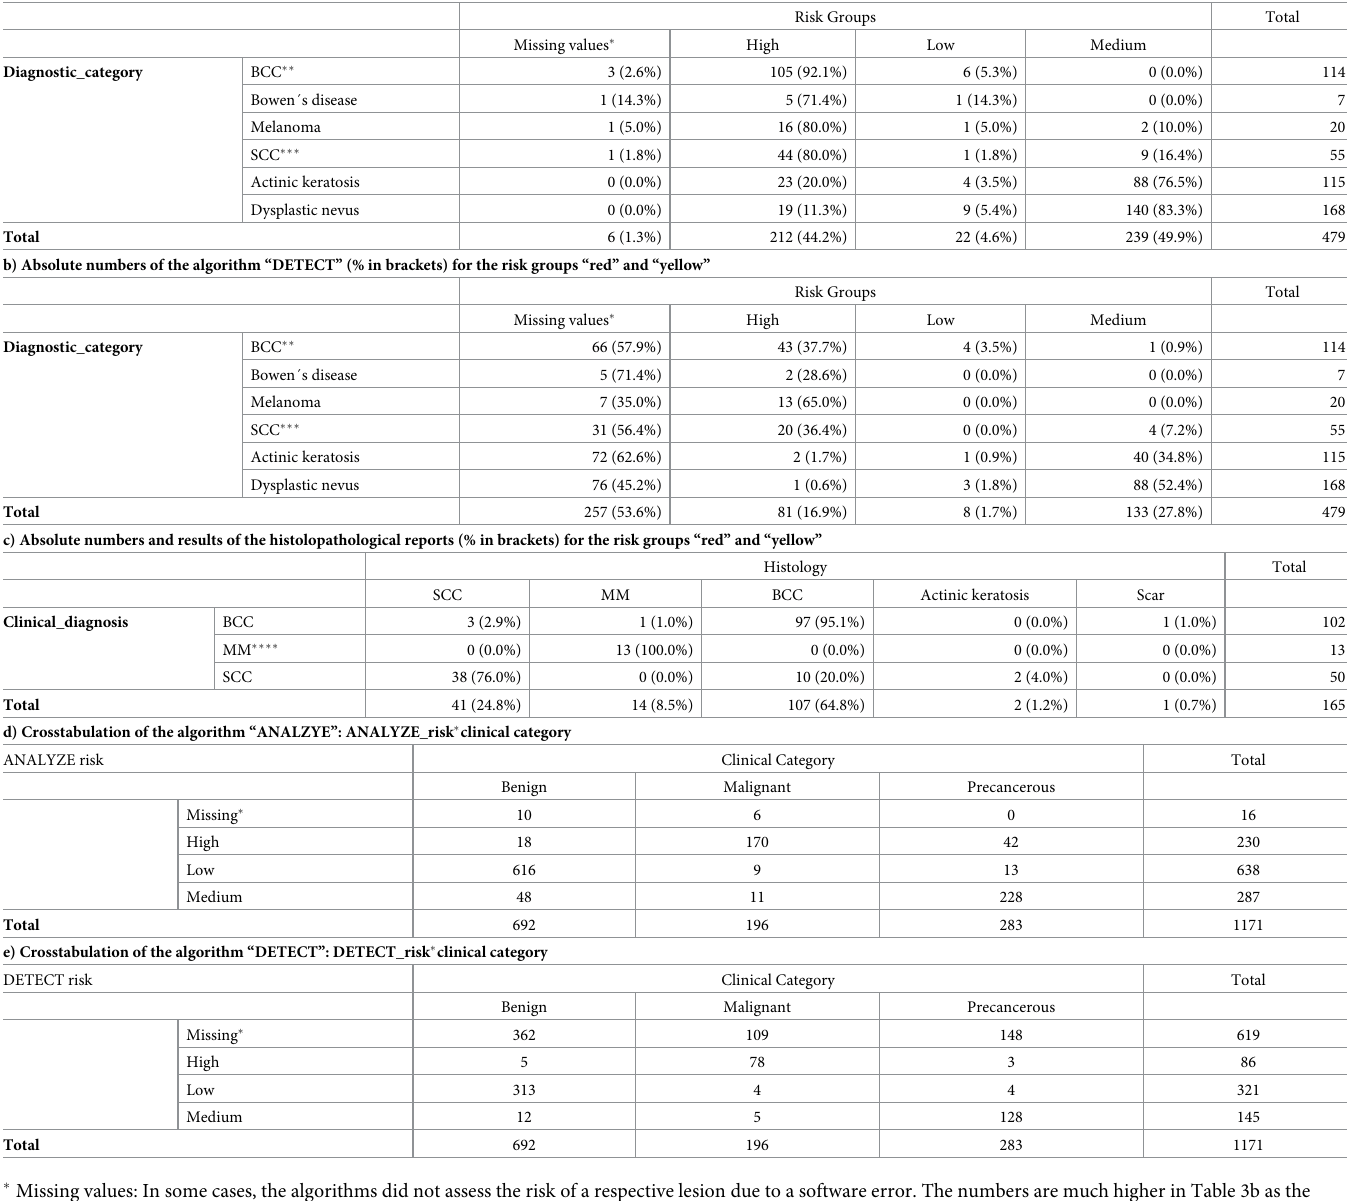
� Missing values: In some cases, the algorithm did not assess the risk for a respective lesion due to a software error. The numbers are much higher than in Table 3d as the DETECT algorithm was developed and tested